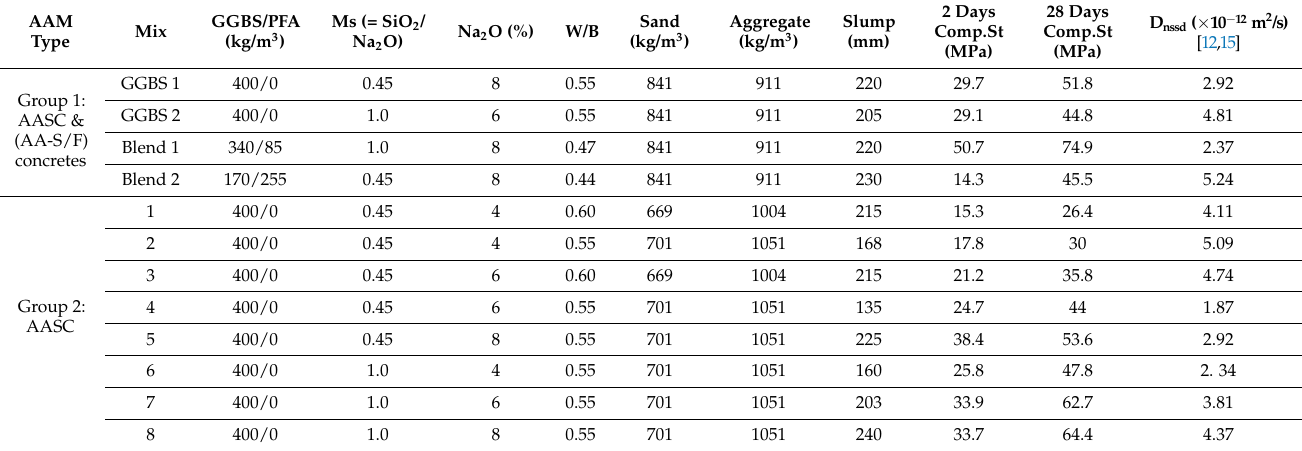
Table 2. The details of two types of AAM concrete mixes and their